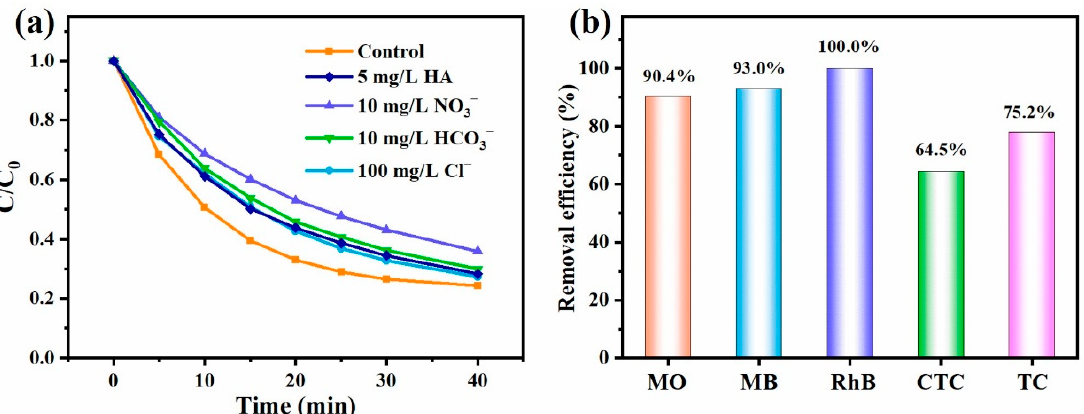
Figure 7. TC degradation with various matrix species ( a ) and degradation of different organic pollutants ( b ) by the CNT-O-H/PDS system (General conditions: 25 °C, natural pH, 0.2 g/L CNT-O-H, 0.4 g/L PDS, 50 mg/L TC/CTC, 20 mg/L MO/RhB, 10 mg/L MB).